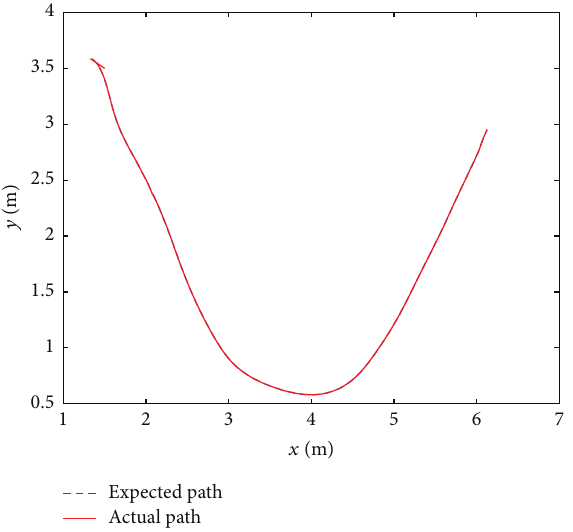
Figure 11: Tracking performance using the derived